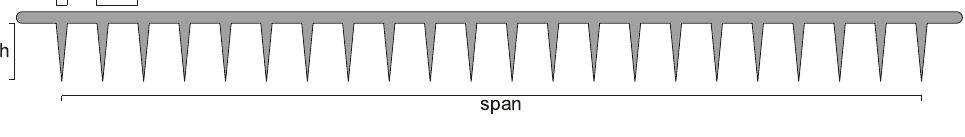
Figure 5. Exposed electrode geometry.